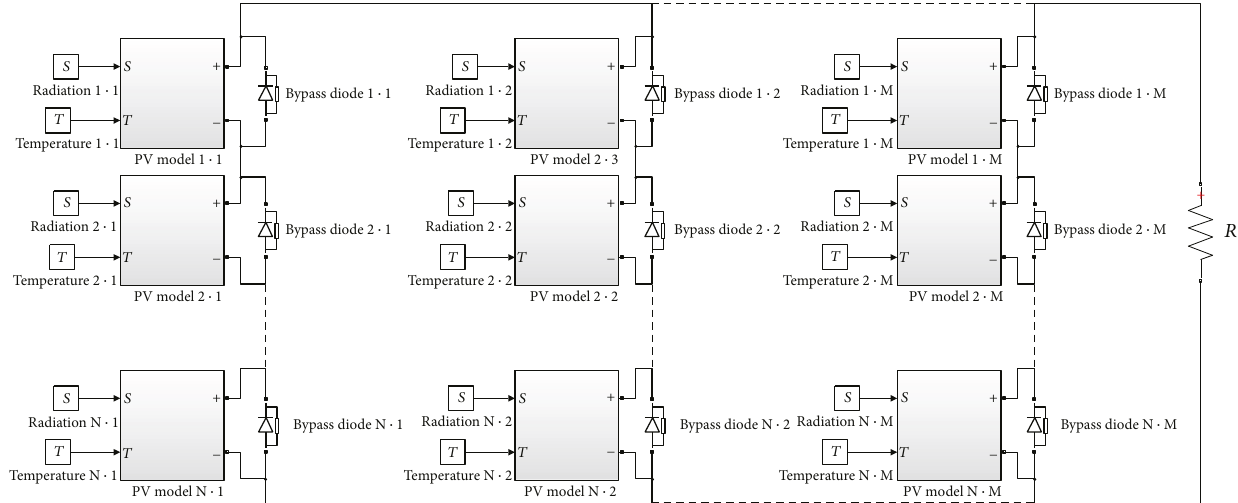
Figure 4: Simulation model of photovoltaic array. By entering di ff erent temperatures and irradiance, we can get the IV/PV curves of PV arrays under di ff erent operating conditions. Table 1: Basic parameters for the module.